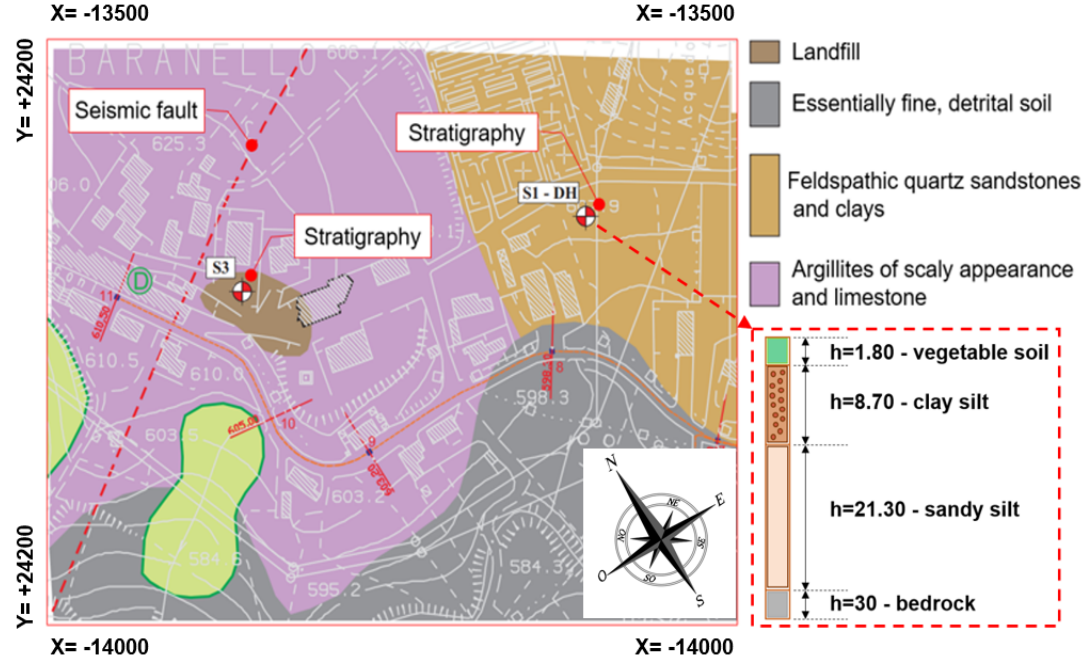
Figure 19. The identification of the in situ geological tests.